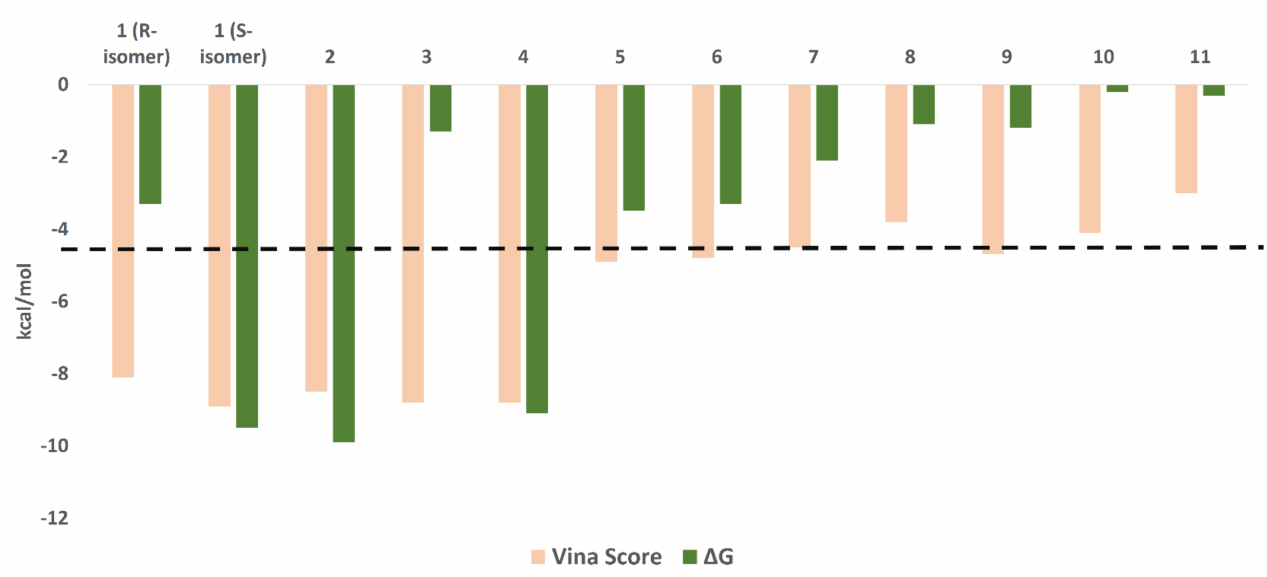
Figure 4. Docking scores and ∆ G values of the isolated compounds ( 1 – 11 ). We set a cut-off at − 7 kcal/mol (black dashed line). Most of the established interactions between each compound and the amino acid residues of the active site (Figure 5) could be overlaid on the structure of the co-crystalized inhibitor (Figure 5D,H) [41]. The binding modes of S and R-isomers of compound 1 were slightly different. The R-isomer established one H-bond with GLN189 through one of its two ketonic oxygens, while the S-isomer established two H-bonds with HIS163 and GLN189 through its two ketonic oxygen atoms, and one additional H-bond with GLY143 via one of its two amide nitrogen atoms (Figure 5A,E). Both isomers established hydrophobic interactions with HIS41, MET49, PHE140, CYS145, and MET165 via their two benzene moieties. The co-crystalized ligand was also connected to GLY143 and HIS163 via H-bonding and to both HIS41 and PHE140 via hydrophobic interactions. Accordingly, the binding mode of the S-isomer was closer to the co-crystalized ligand than that of the